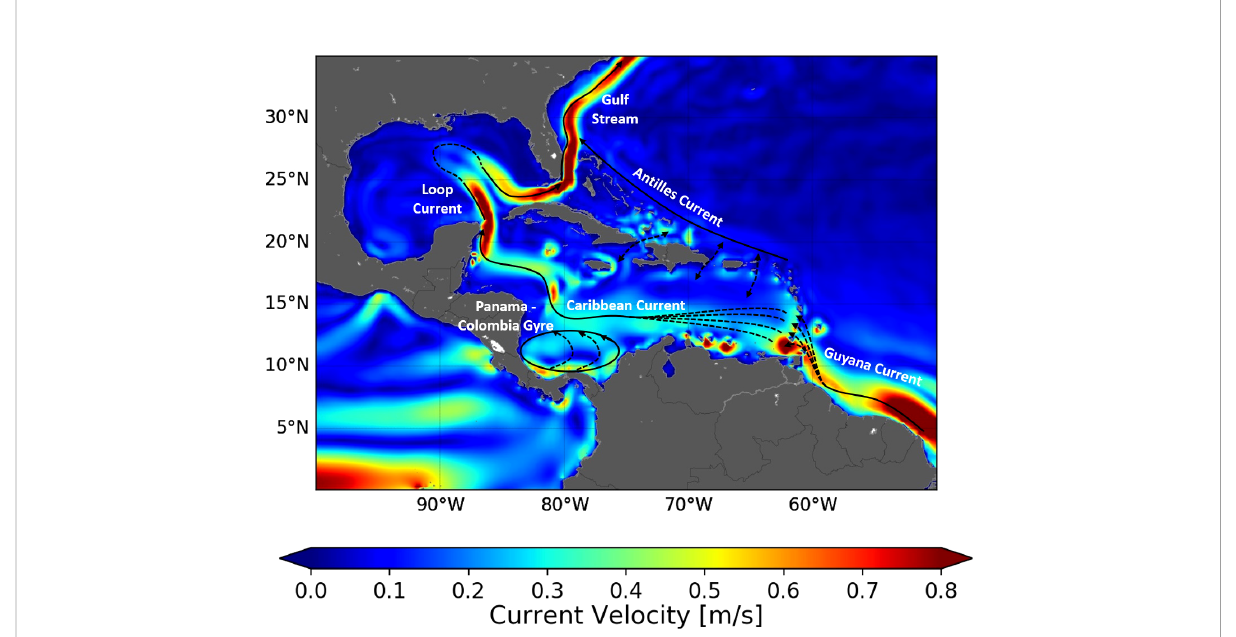
FIGURE 2 Schematic map of the surface circulation in the WCR. The colored background represents the current speed averaged over the whole GLORYS- 1 ocean reanalysis